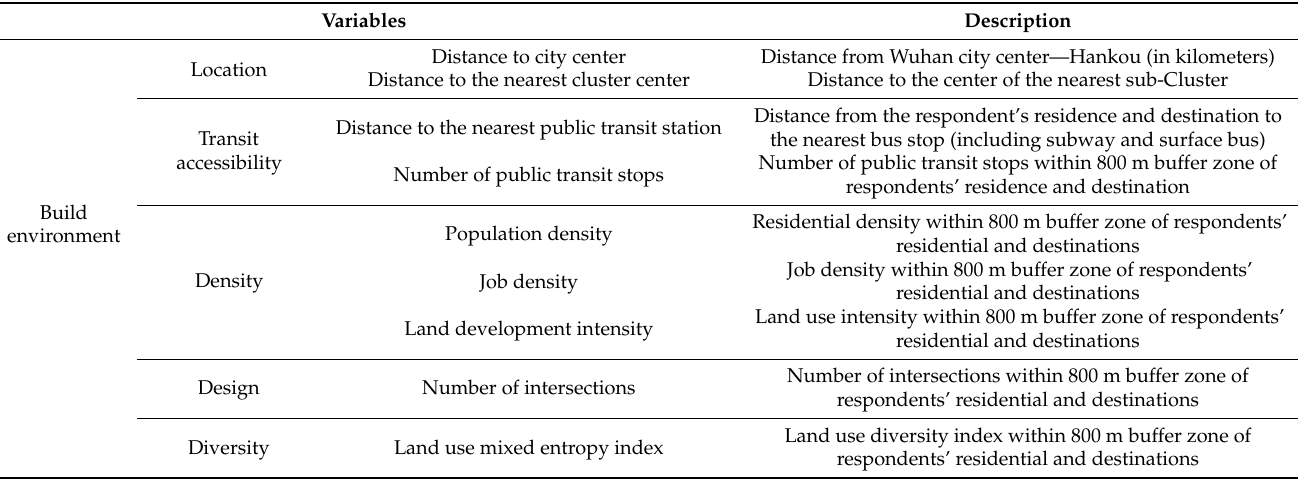
Table 2. Built environment information